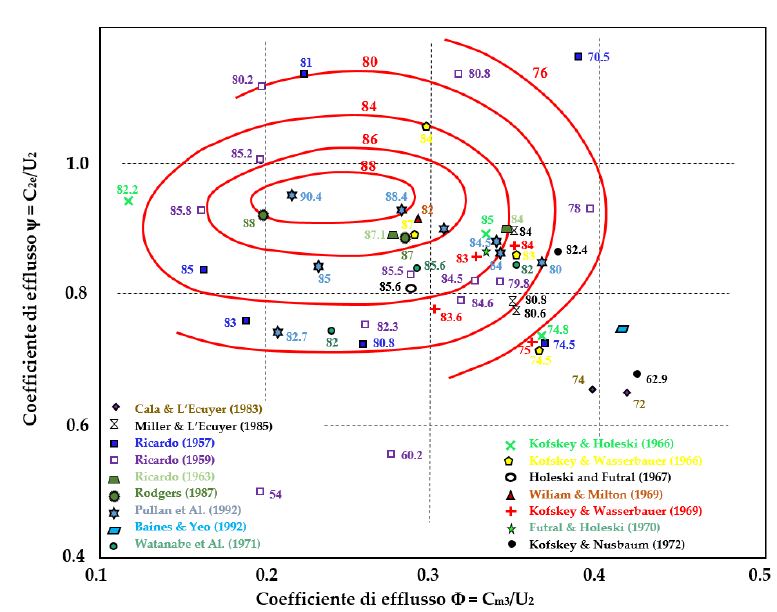
Figure 6. Chen and Baines maps.